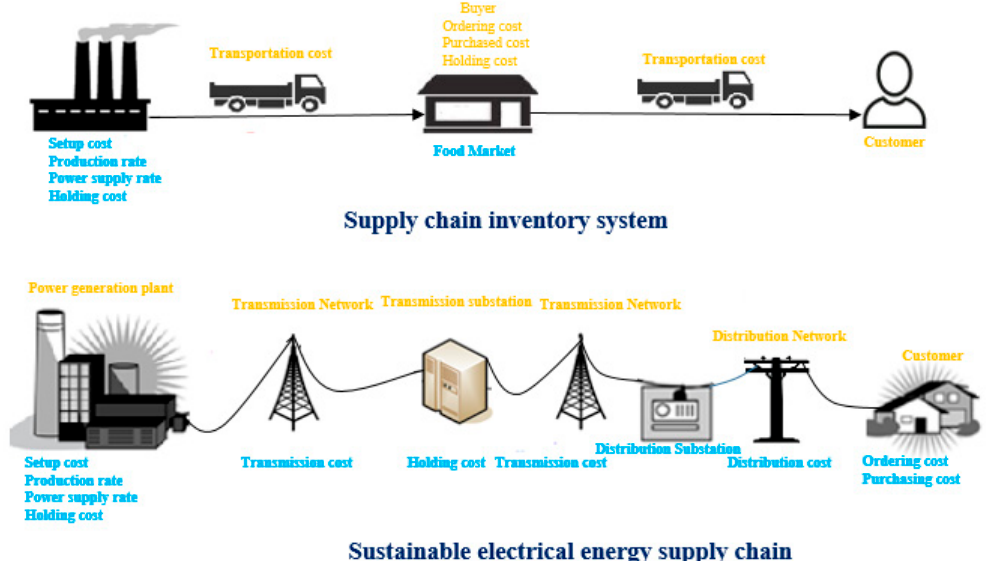
Figure 1. Supply chain inventory and sustainable electrical supply chain.